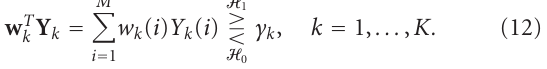
3.2. Collaborative Detection. Let us consider the signal received by each CR in one single narrow subband. The structure of a narrowband energy detector is (2) for each k th